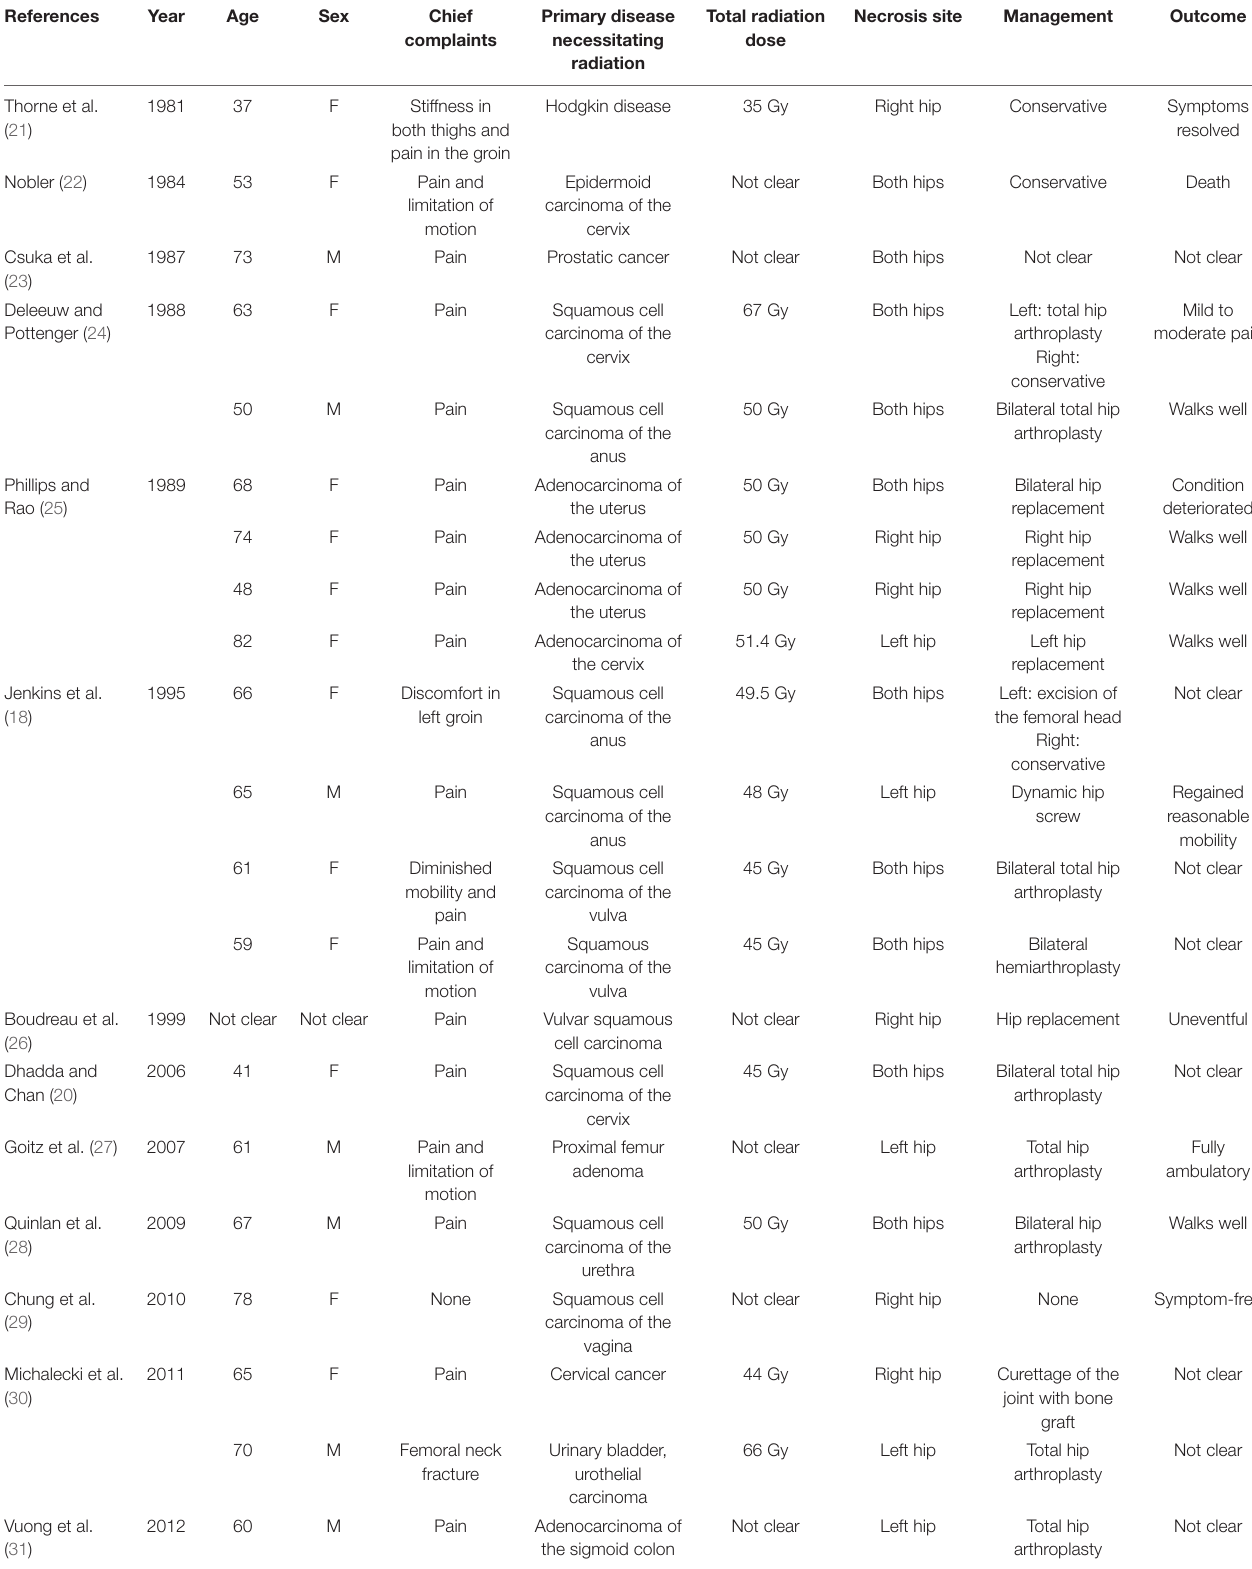
TABLE 1 | Clinical characteristics of osteoradionecrosis of the